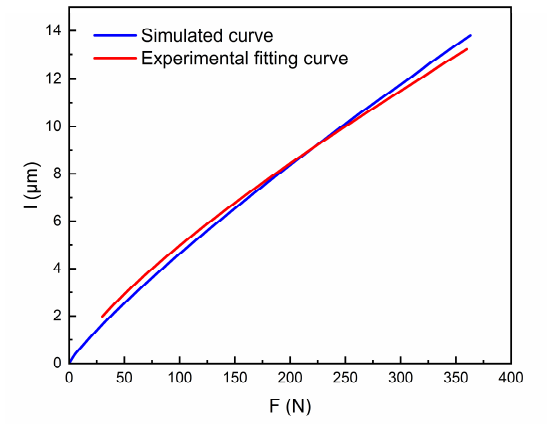
Figure 9. Comparison of F-l curve of bearing’s 2D model and fitting curve of stickout measuring experiment